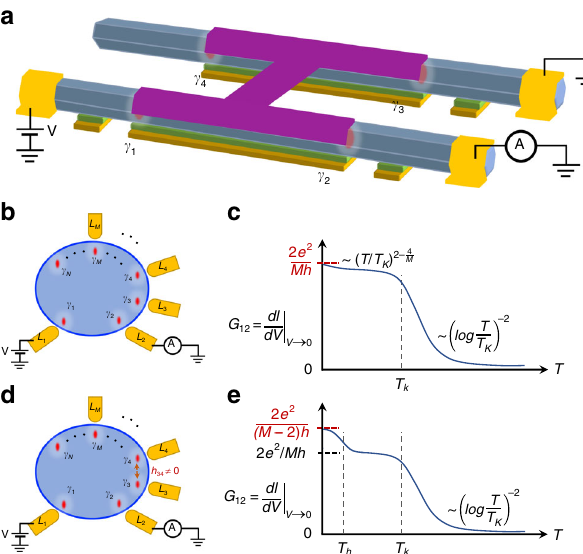
Fig. 6 Topological Kondo effect. a Schematic experimental setup supporting a test of topological Kondo effect with four MZMs and three normal leads. Two parallel semiconductor nanowires are connected by an s-wave superconductor (the “ H-shape ” junction, purple). b Schematics for a general topological Kondo system with N MZMs and M normal leads, where N = 4 and M = 3 in a . Assuming no spatial overlap between different MZMs, the conductance temperature dependence ( c ) shows a crossover between a weak coupling trivial fi xed point at high temperature to a S O 2 ( M ) non-trivial non-Fermi-liquid (NFL) fi xed point ( G 12 = 2 e 2 / Mh ) at low temperature, separated by the Kondo temperature T K . d – e For the case where two MZMs (e.g., γ 3 and γ 4 ) have a weak hybridization, the system initially tries to crossover to S O 2 ( M ) NFL fi xed point, but fi nally turn to